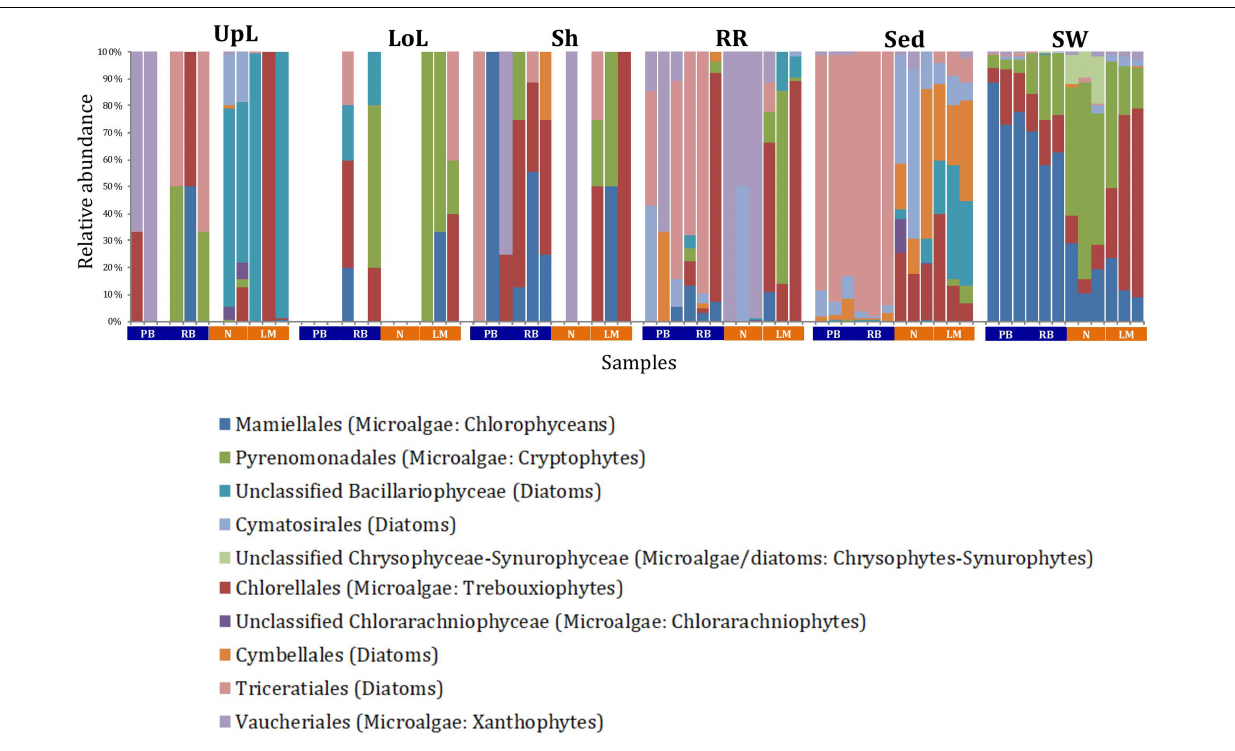
FIGURE 8 | Microalgal community composition across seagrass microenvironments. Beta diversity of microalgal microbiomes across the six microenvironments within the plant and its surroundings. Triplicate samples per microenvironment within each of the four sampling sites ( n = 72) are colored by taxonomic order. Unique OTUs were summarized at the species level, and the representation of taxonomic groups within each sample are plotted. Only representative species with a relative abundance > 1% in all samples are shown to help remove visual clutter. UpL, upper leaf; LoL, lower leaf; Sh, sheath; RR, roots and rhizomes; Sed, sediment;